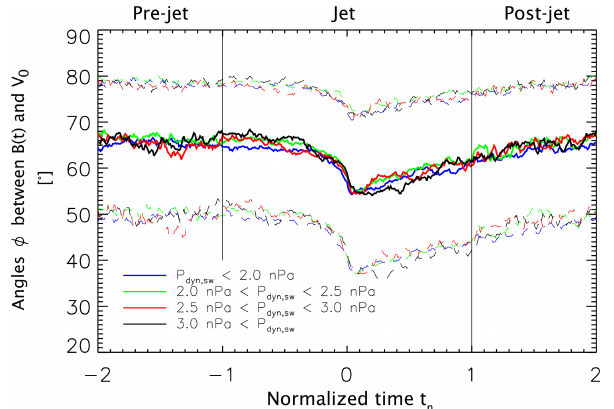
Figure 7. Superposed epoch analyses of the angle φ B , V tion of the upstream solar-wind dynamic pressure P dyn , sw . As in Fig. 3, solid lines show median values and dashed lines show upper and lower quartiles.